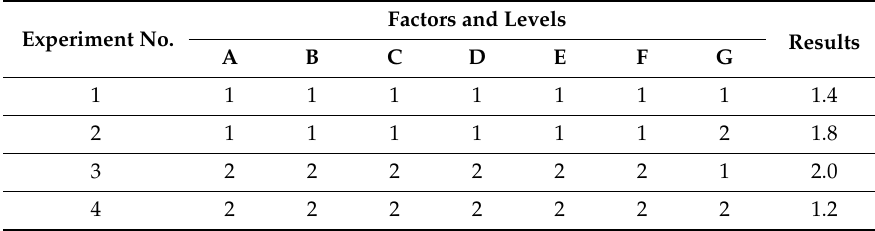
Table 1. Insu ffi cient consideration of each factor during the experimental design could lead to biased results.